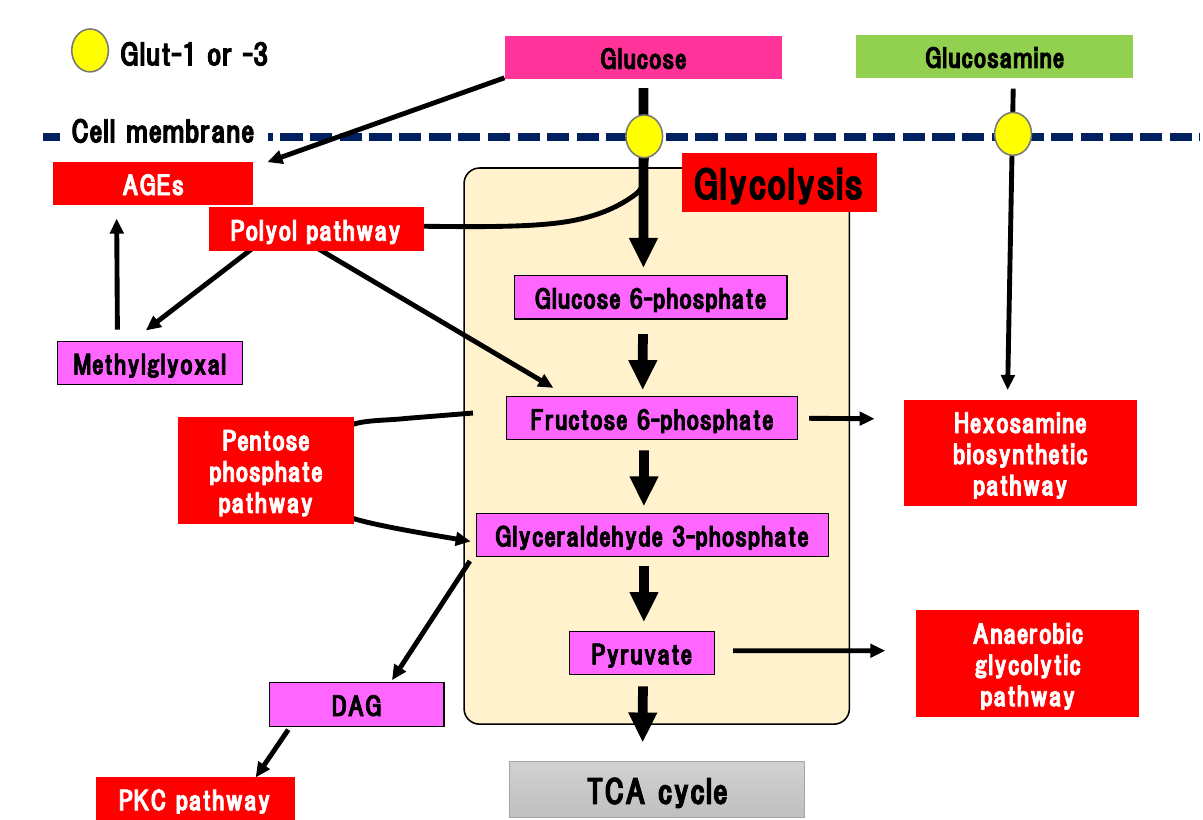
Figure 1. Collateral glucose-utilizing pathways associated with diabetic polyneuropathy. Glycolysis is a central pathway involved in glucose metabolism. There are several collateral glucose-utilizing pathways, such as the polyol pathway, PKC pathway, glycation, hexosamine biosynthetic pathway including glucosamine metabolism, pentose phosphate pathway, and anaerobic glycolytic pathway. AGE, advanced glycation end-product; DAG, diacylglycerol; Glut, glucose transporter; PKC, protein kinase C; TCA cycle, tricarboxylic acid